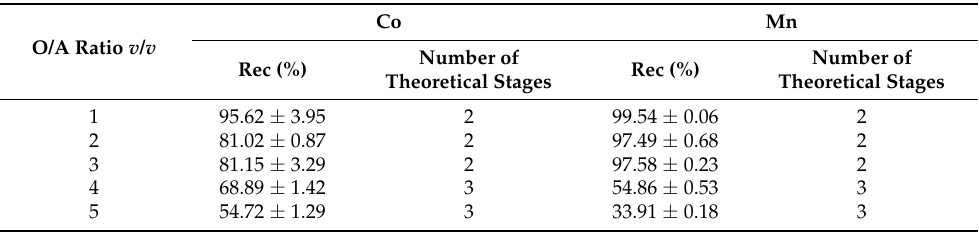
Table 6. Co-Mn stripping rate and theoretical stages required for complete stripping at different O/A ratios using sulfuric acid 0.2 M (feed organic Cyanex ® 272 10% v / v , Co 3.2 g/L, Mn 0.16 g/L).